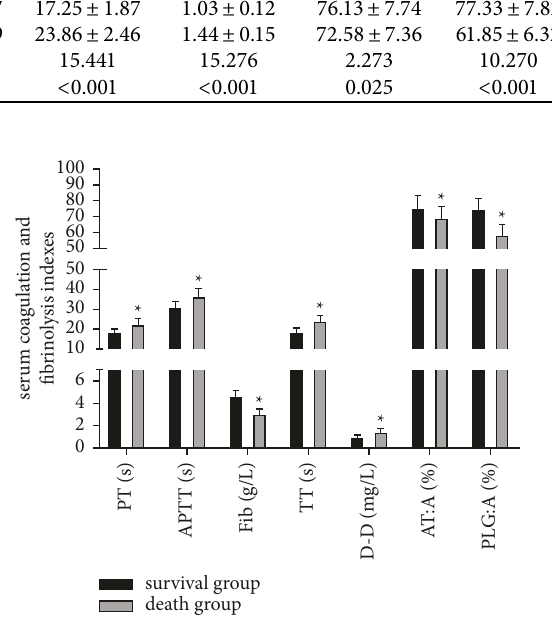
Figure 2: Comparison of serum coagulation and fibrinolysis in- dexes in each group. PT: prothrombin time, APTT: activated partial thromboplastin time, Fib: fibrinogen, TT: thrombin time, D-dimer, D-D: D-dimer, AT: A: antithrombin activity, and PLG: A: plas- P minogen activity; 0 . 05 compared with the survival ∗ <